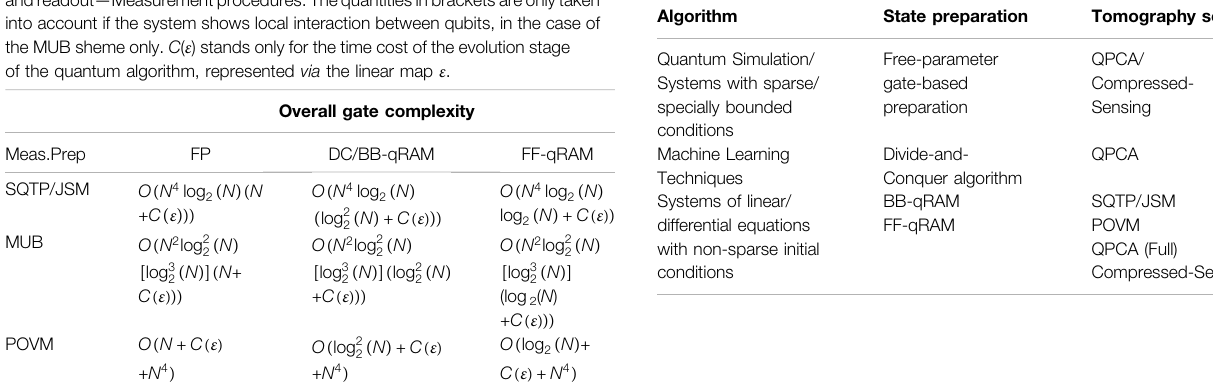
TABLE 4 | Quantum algorithms and possible choices for input state preparation and tomography